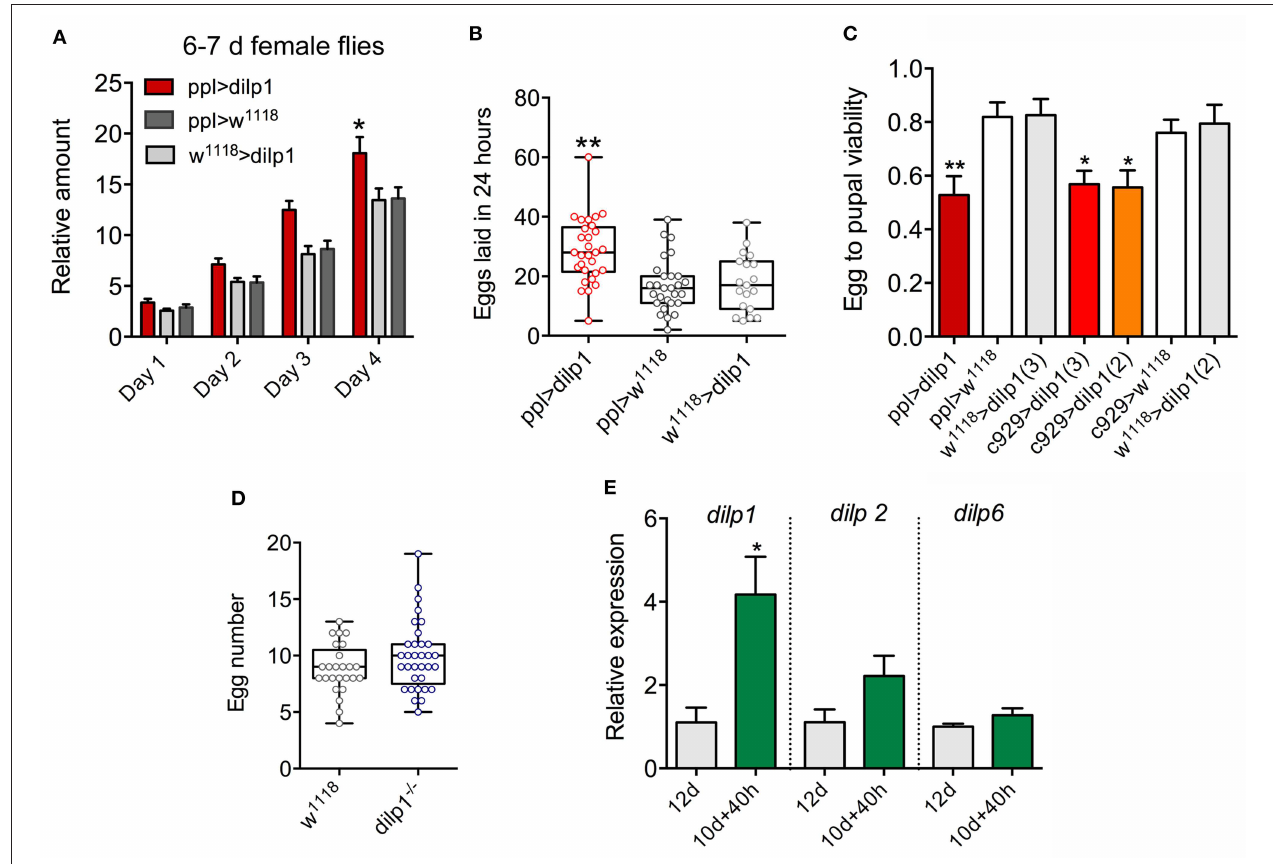
FIGURE 8 | Overexpression of dilp1 affects food intake and fecundity. (A) In CAFE assay, the dilp1 overexpressing flies (6- to 7-day-old females) display increased food intake over 4 days (cumulative data shown). Data are presented as means ± S.E.M, n = 23–24 flies from three independent replicates (* p < 0.05, two-way ANOVA followed by Tukey’s test). (B) Number of eggs laid in 24h by 6- to 7-day-old flies. We analyzed 19–29 pairs of flies from 3 replicates (** p < 0.01, one-way ANOVA followed by Tukey’s test). (C) The egg to pupal viability is diminished in flies with dilp1 expressed in fat body ( ppl -Gal4) and neuroendocrine cells [ c929 -Gal4, using two different UAS- dilp1 (2 and 3)]. Data are presented as means ± S.E.M; more than 276 eggs from 6 replicates were monitored (* p < 0.05, unpaired Student’s t -test). (D) Number of eggs in ovaries of 3-day-old flies is not affected in dilp1 mutants. A total of 25–33 flies from three replicates were analyzed. (E) dilp1 mRNA is upregulated during starvation for 40h in 10-day-old adult w 1118 flies, compared to 12-day-old flies fed normal food, as monitored by qPCR. No effect was seen on dilp2 and dilp6 levels. Data are presented as means ± S.E.M.; 3 replicates with 10 flies in each replicates were monitored (* p < 0.05, unpaired Student’s t